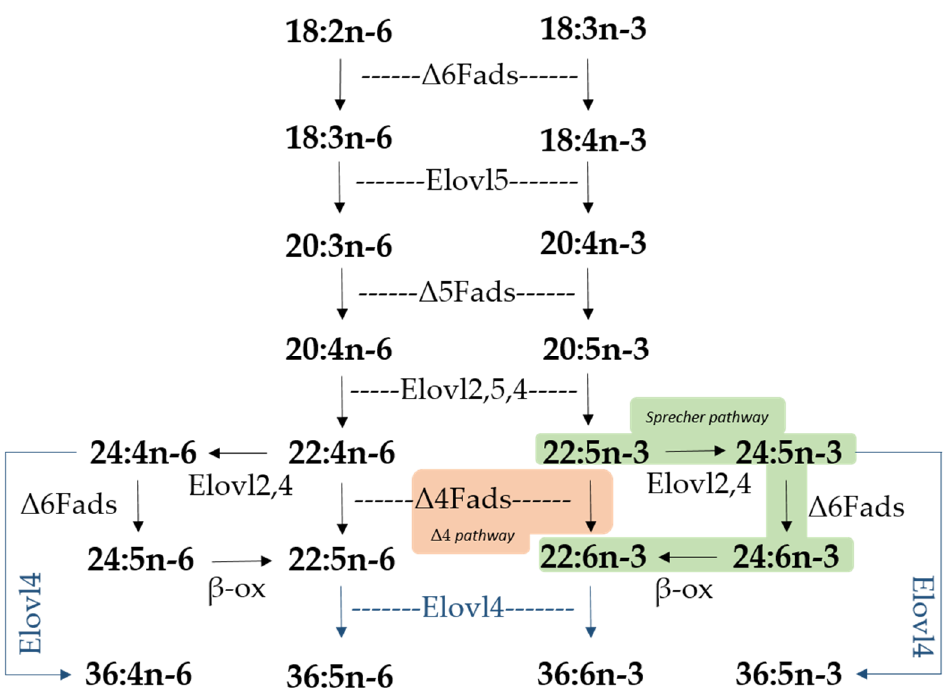
Figure 1. Biosynthetic pathways of long-chain (LC-PUFA; C 20–24 ) and very long-chain polyunsaturated fatty acids (VLC-PUFA; > C 24 ) in fish. Desaturation reactions are mediated by fatty acyl desaturases (Fads), whereas elongation reactions are catalyzed by elongation of very long-chain fatty acid (Elovl) proteins. Microsomal β -oxidation reactions are denoted as “ β -ox”. Two pathways for docosahexaenoic acid (DHA; 22:6n-3) biosynthesis from docosapentaenoic acid (DPA; 22:5n-3) are indicated, namely the Sprecher pathway (green background) and the ∆ 4 pathway (orange background). Elongation reactions leading to VLC-PUFA biosynthesis of up to C 36 are indicated with blue arrows. Note the fish species studied herein ( Sparus aurata and Solea senegalensis ) lack elovl2 in their genomes [2].